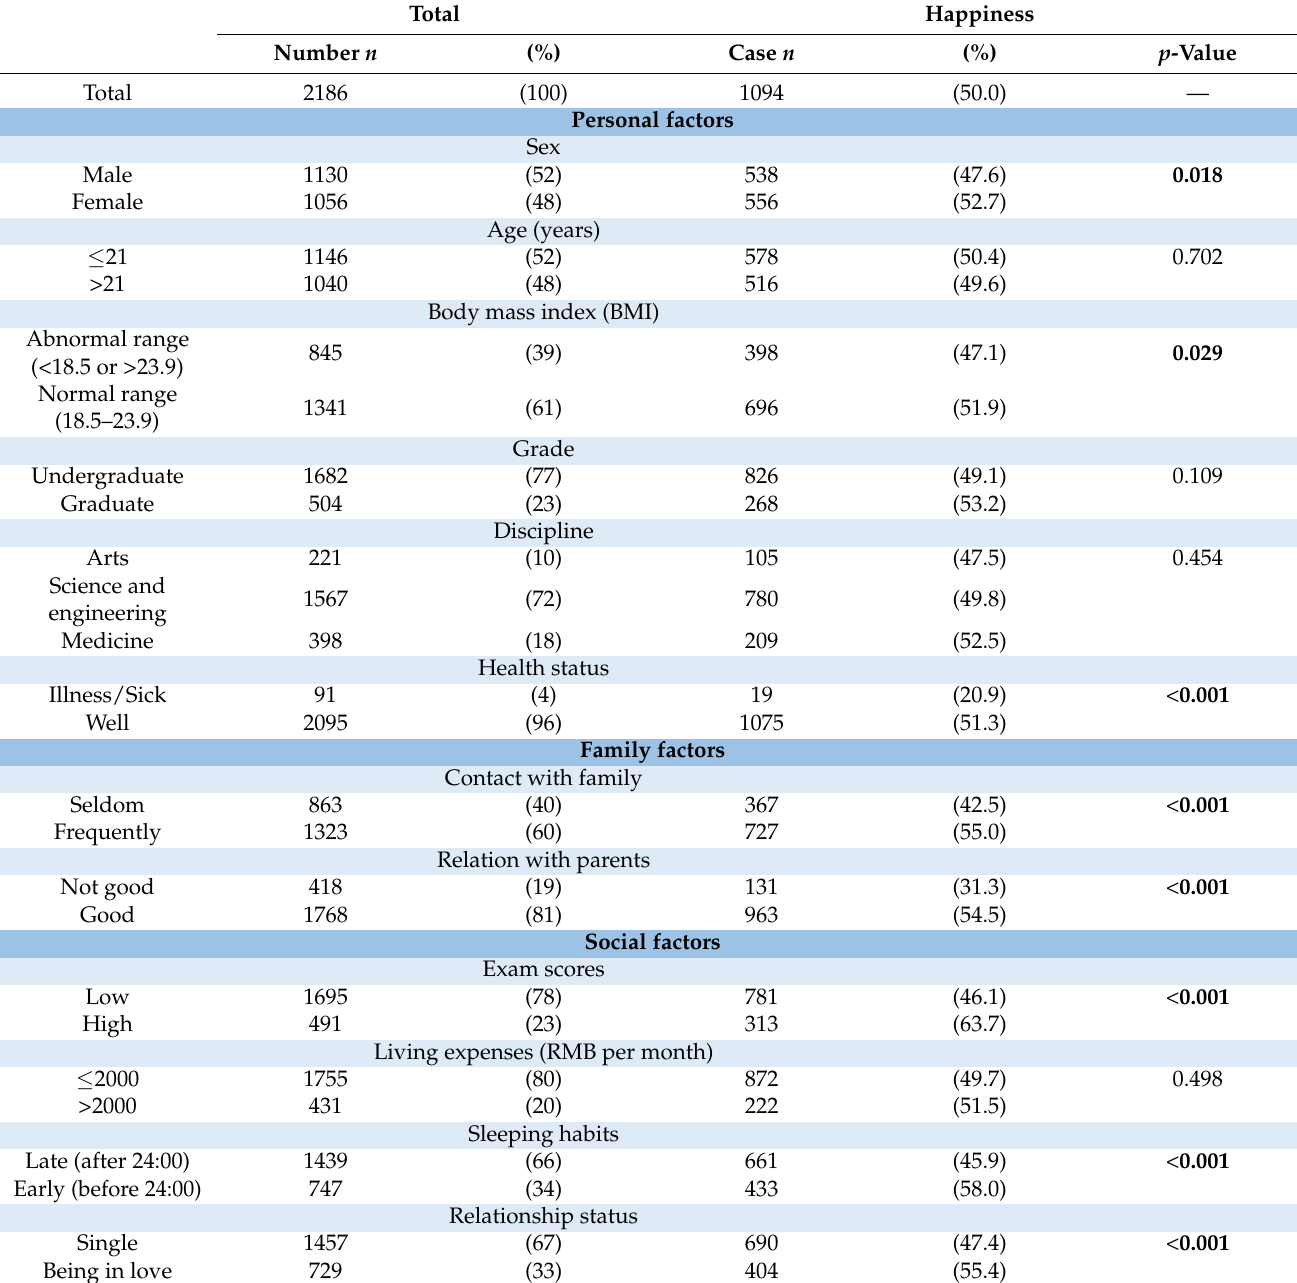
Table 1. Covariate information for the students stratified by happiness in this study ( n =